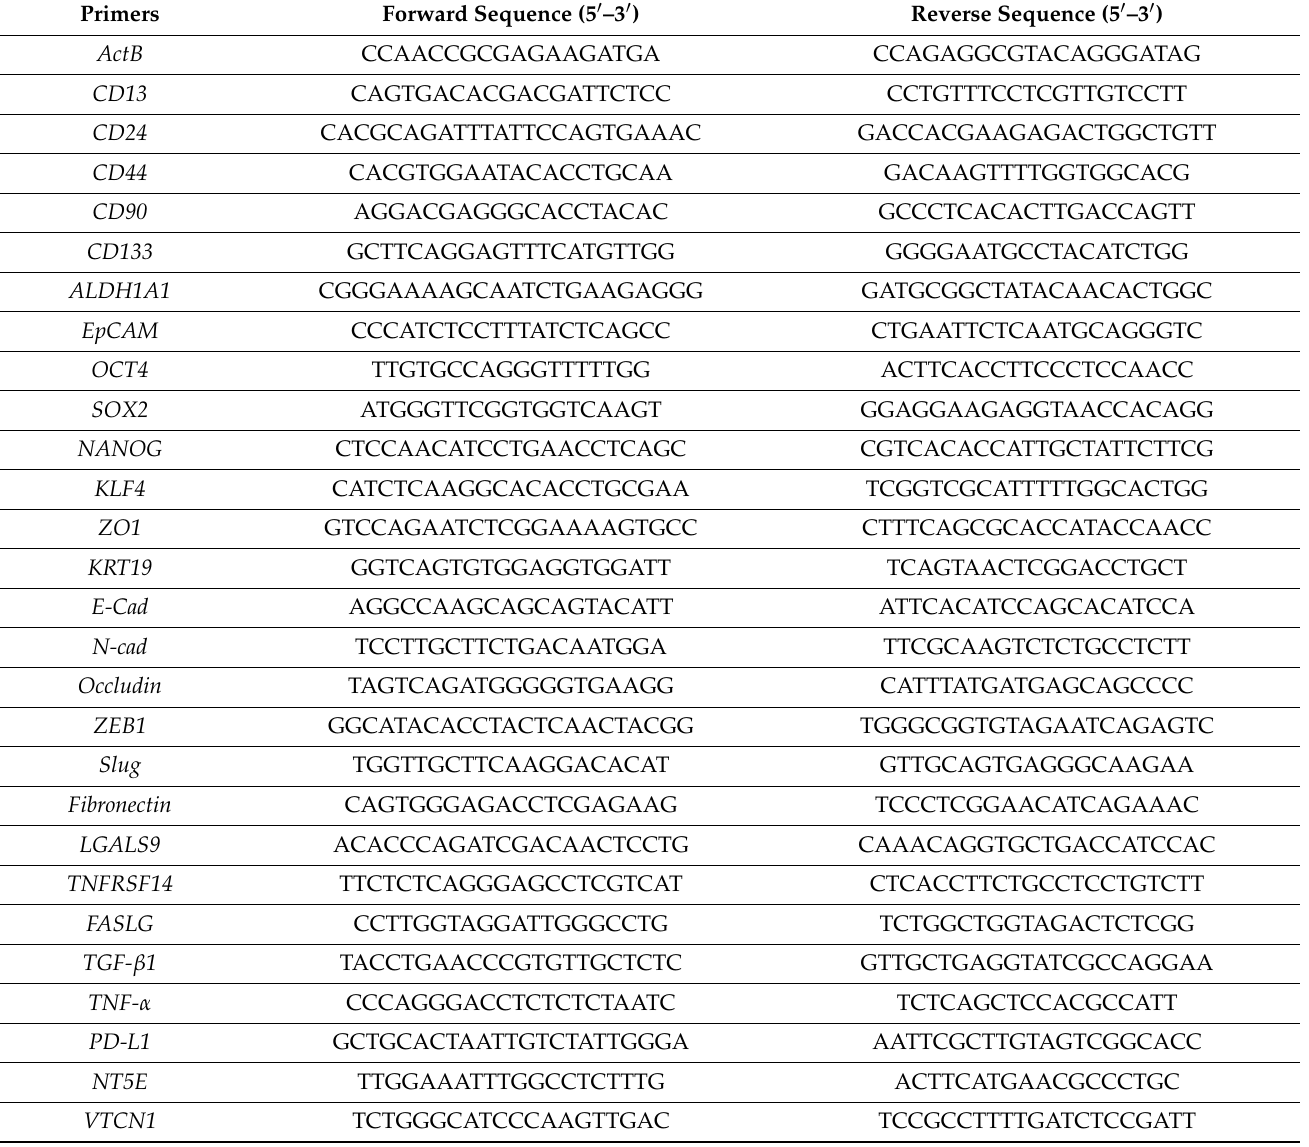
Table 1. List of qRT-PCR